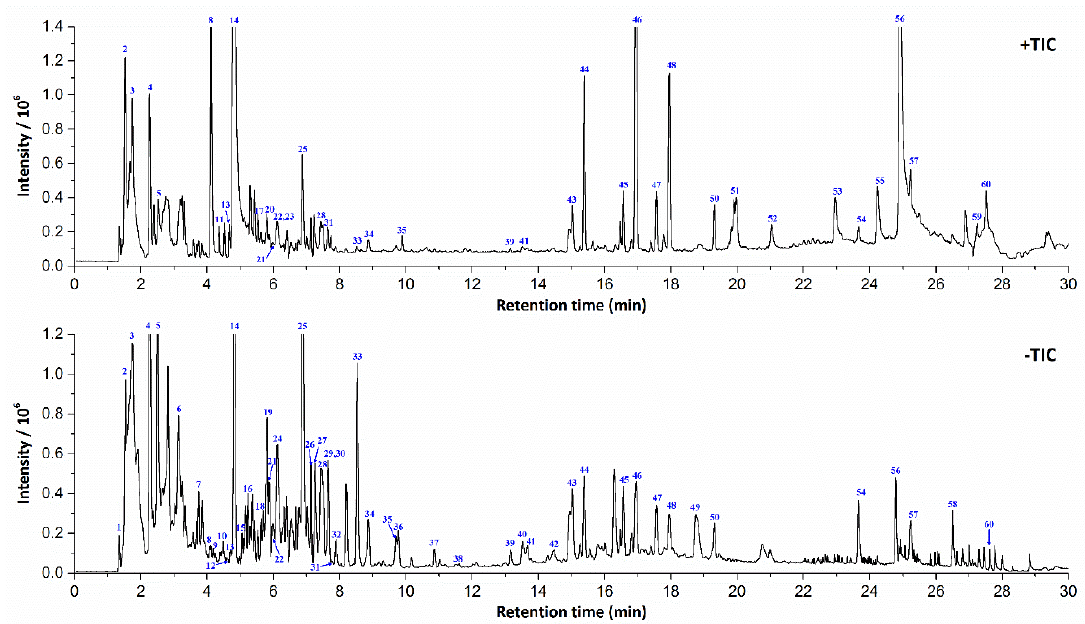
Figure 1. The representative total ion current chromatogram (TIC) of Bolbostemma paniculatum extracts in positive and negative ESI modes.